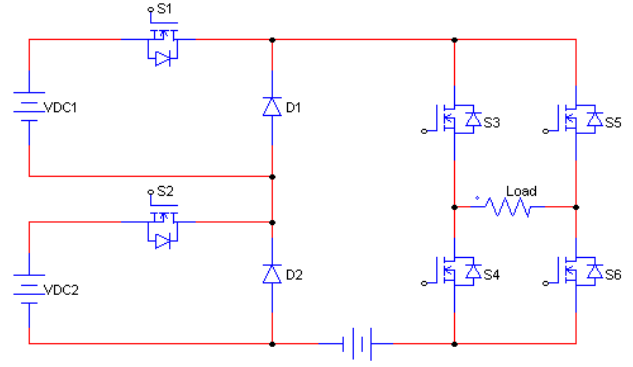
Figure 19. Circuit for seven-level H-bridge inverter. Electronics 2020 , 9 , x FOR PEER REVIEW